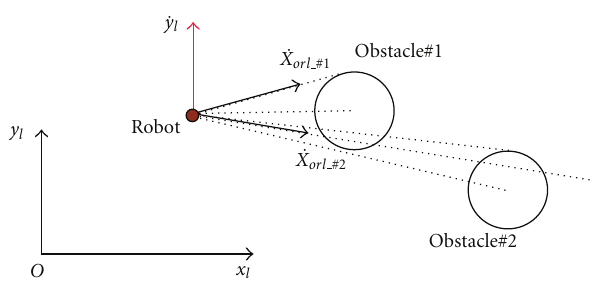
Figure 12: Multiple obstacle avoidance.